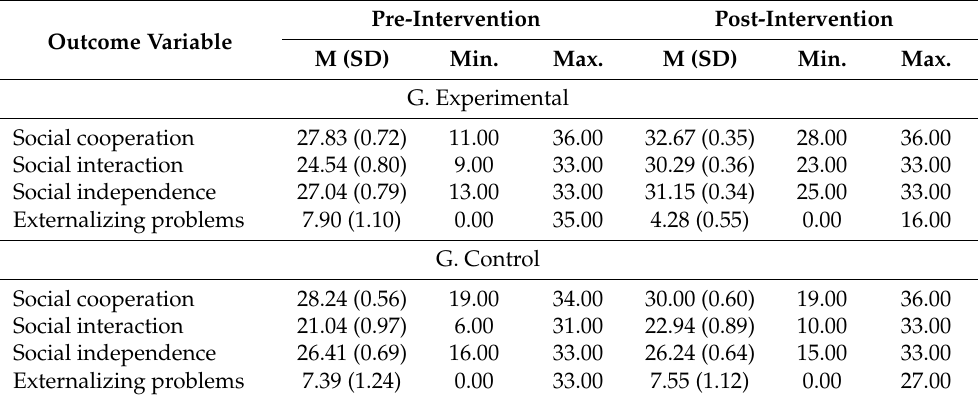
Table 2. Descriptive dates in social skills and externalizing problems by groups and